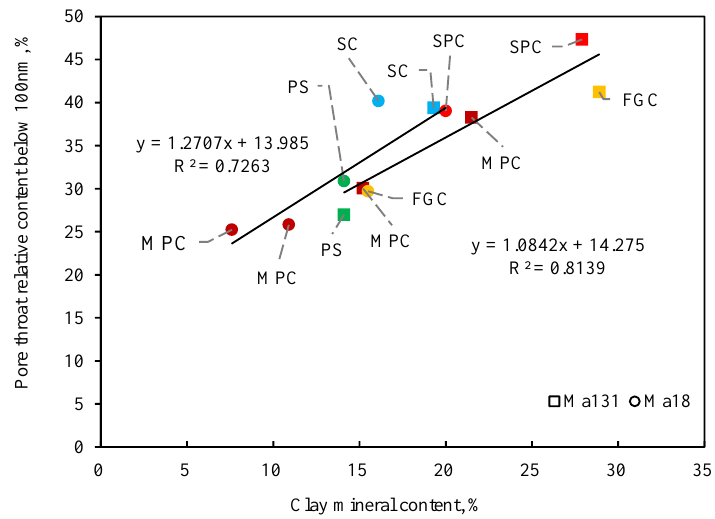
Figure 12. Correlation between the clay content and the proportion of 100 nm pore throats.